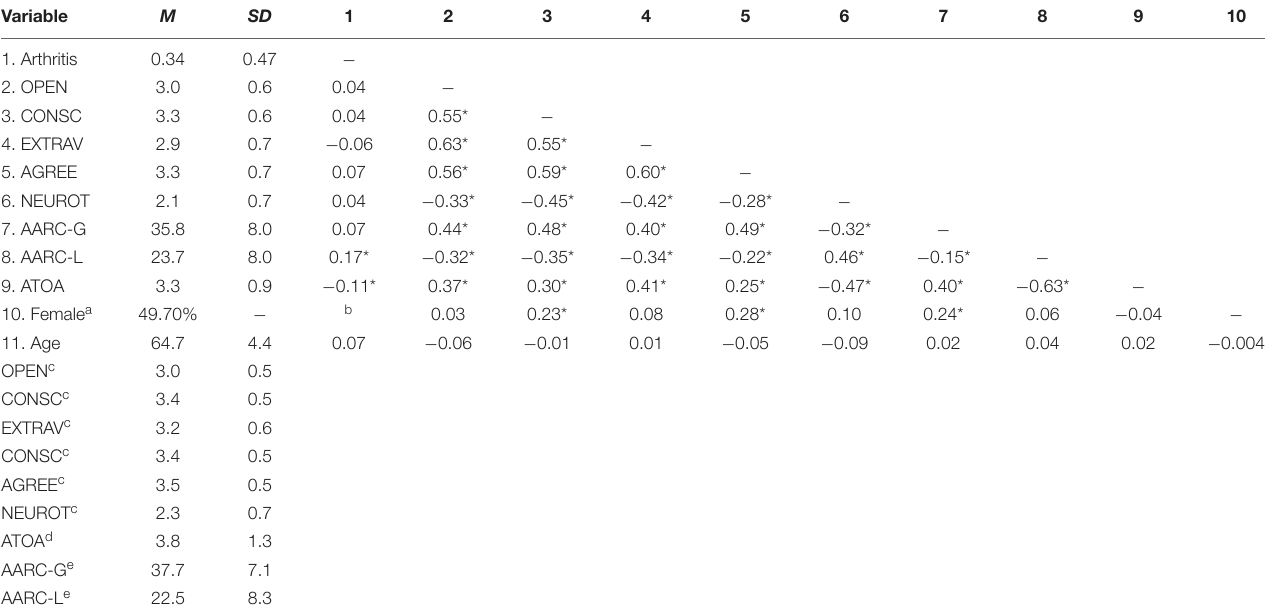
TABLE 1 | Descriptive statistics and correlations for study variables ( n =